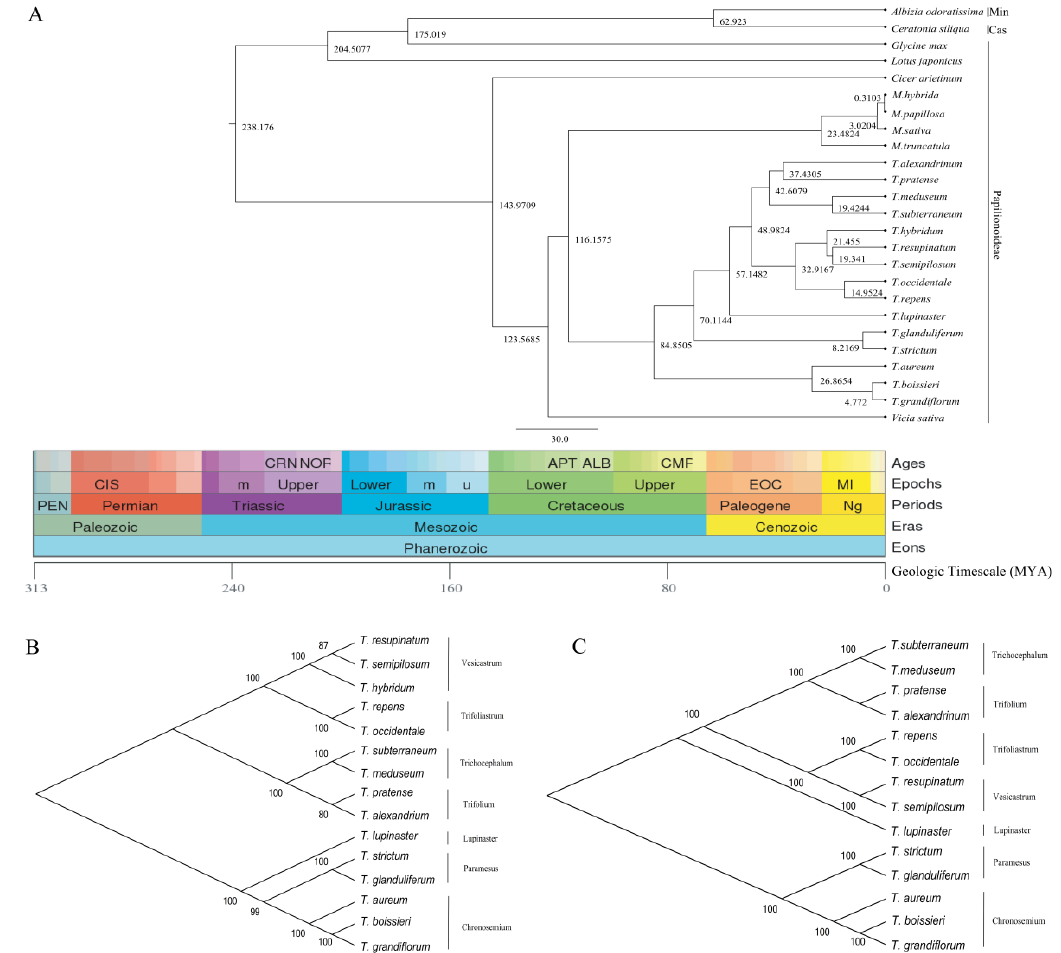
Figure 7. ( A ) BEAST chronogram of the 25 Leguminosae species based on the 41 common protein-coding genes and the phylogenetic trees constructed using rpoC2 gene ( B ) and ycf1 gene ( C , ycf1 gene was absent in T. hybridum ). Geologic timescale was obtained from TIMETREE, time is shown in millions of years (MYA). Min, Mimosaceae; Cas, Caesalpinioideae. The over 50% bootstrap support values were showed in each main branch.